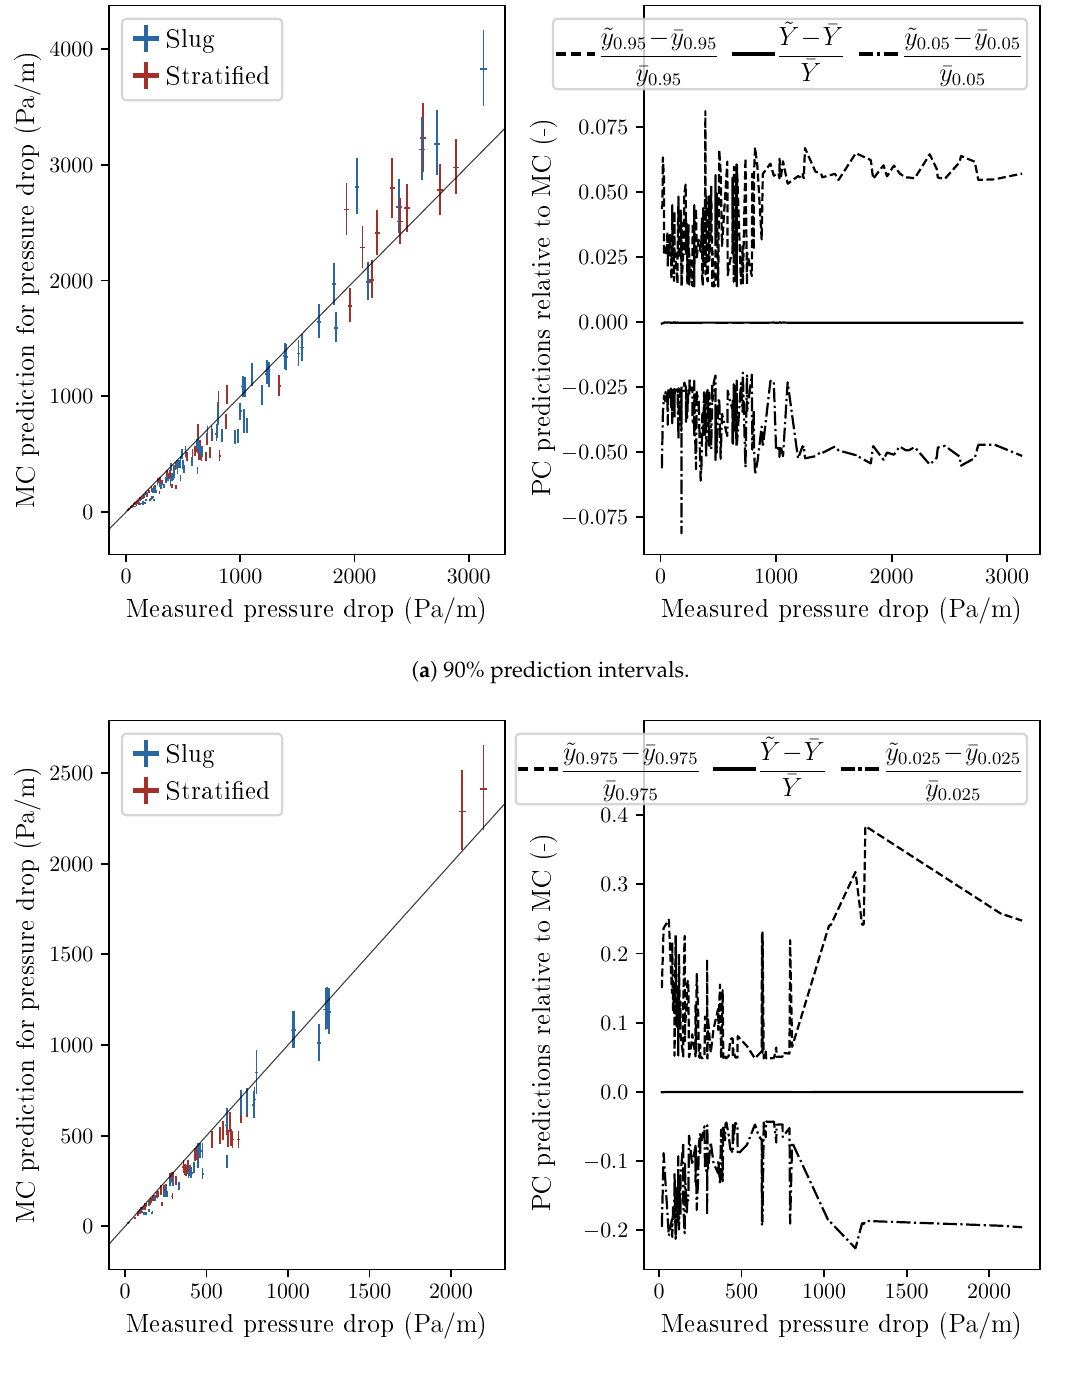
Figure 9. ( Left ) Predicted versus measured pressure drop for 194 experiments. The diagonal line is where the coordinates are equal. The first axis gives measured value with two standard errors either way. The second axis is predicted mean, lower quantile and upper quantile. Slug experiments are blue, and stratified ones are red. ( Right ) The relative difference in PC predictions compared to MC predictions with respect to measured pressure drop. Upper quantiles (dashed), means (solid) and lower quantiles